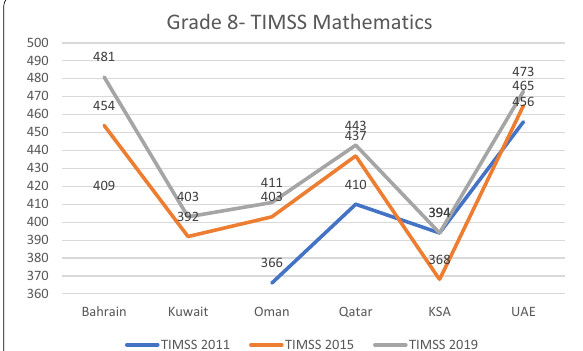
Fig. 3 Grade 8 TIMSS Mathematics performance in GCC